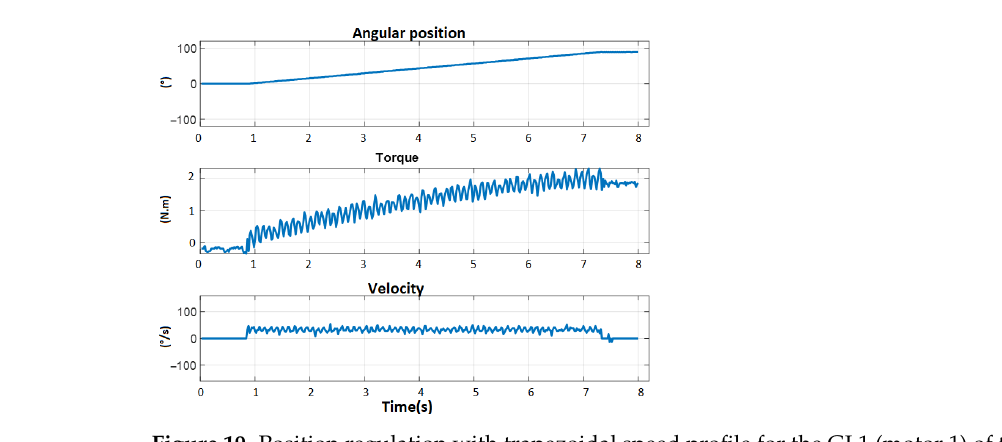
Figure 19. Position regulation with trapezoidal speed profile for the GL1 (motor 1) of the left arm. In this way, we obtain in Figure 20 and Table 5, repeating the same experiment at different speeds and for each motor, the friction maps with the missing coefficients for the mathematical model.